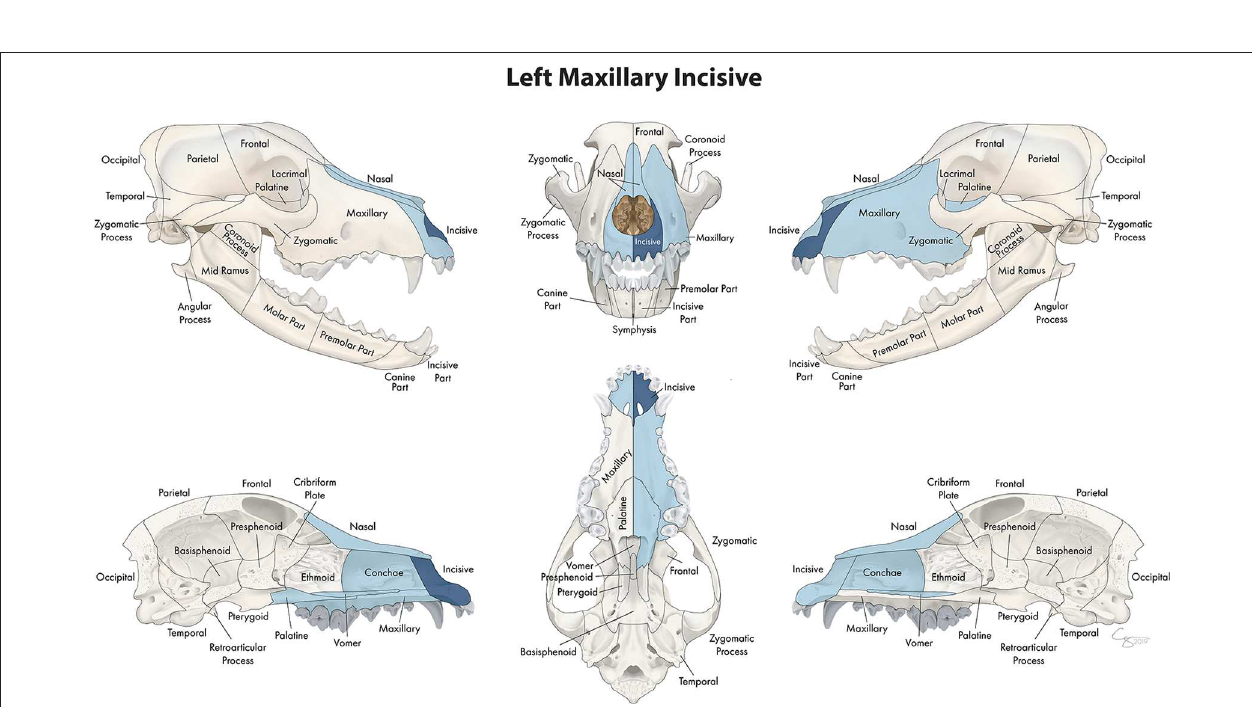
FIGURE 7 | Significant bones or regions fractured concurrently with the incisive bone. When the incisive bone was the region of interest, the vomer, ipsilateral maxillary and palatine bones, contralateral incisive bone, and bilateral conchae and nasal bones fractured concurrently. Although the left incisive bone is shown, when the right incisive bone was the region of interest, a mirror image of concurrently fractured locations